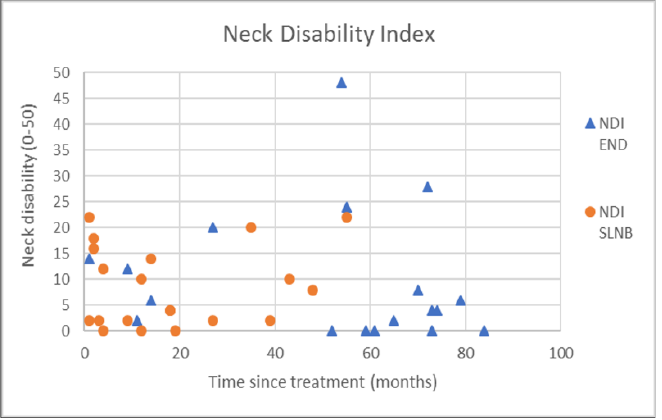
Figure 3. Neck disability index (NDI) in relation to time since treatment.